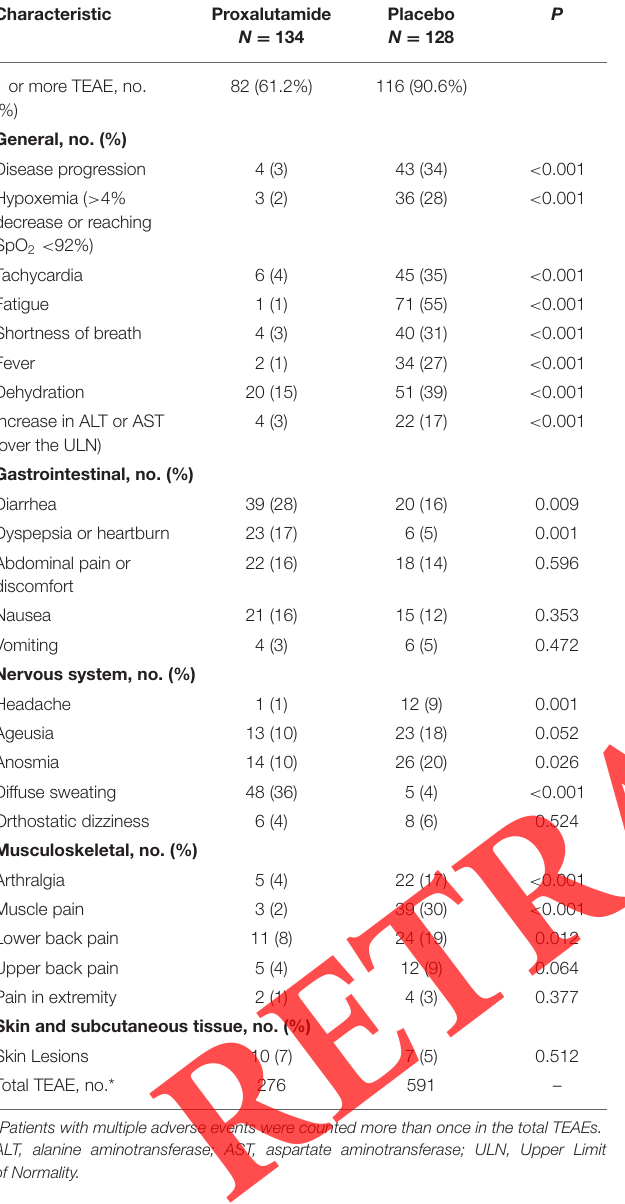
TABLE 3 | Summary of treatment emergent adverse events (TEAEs).